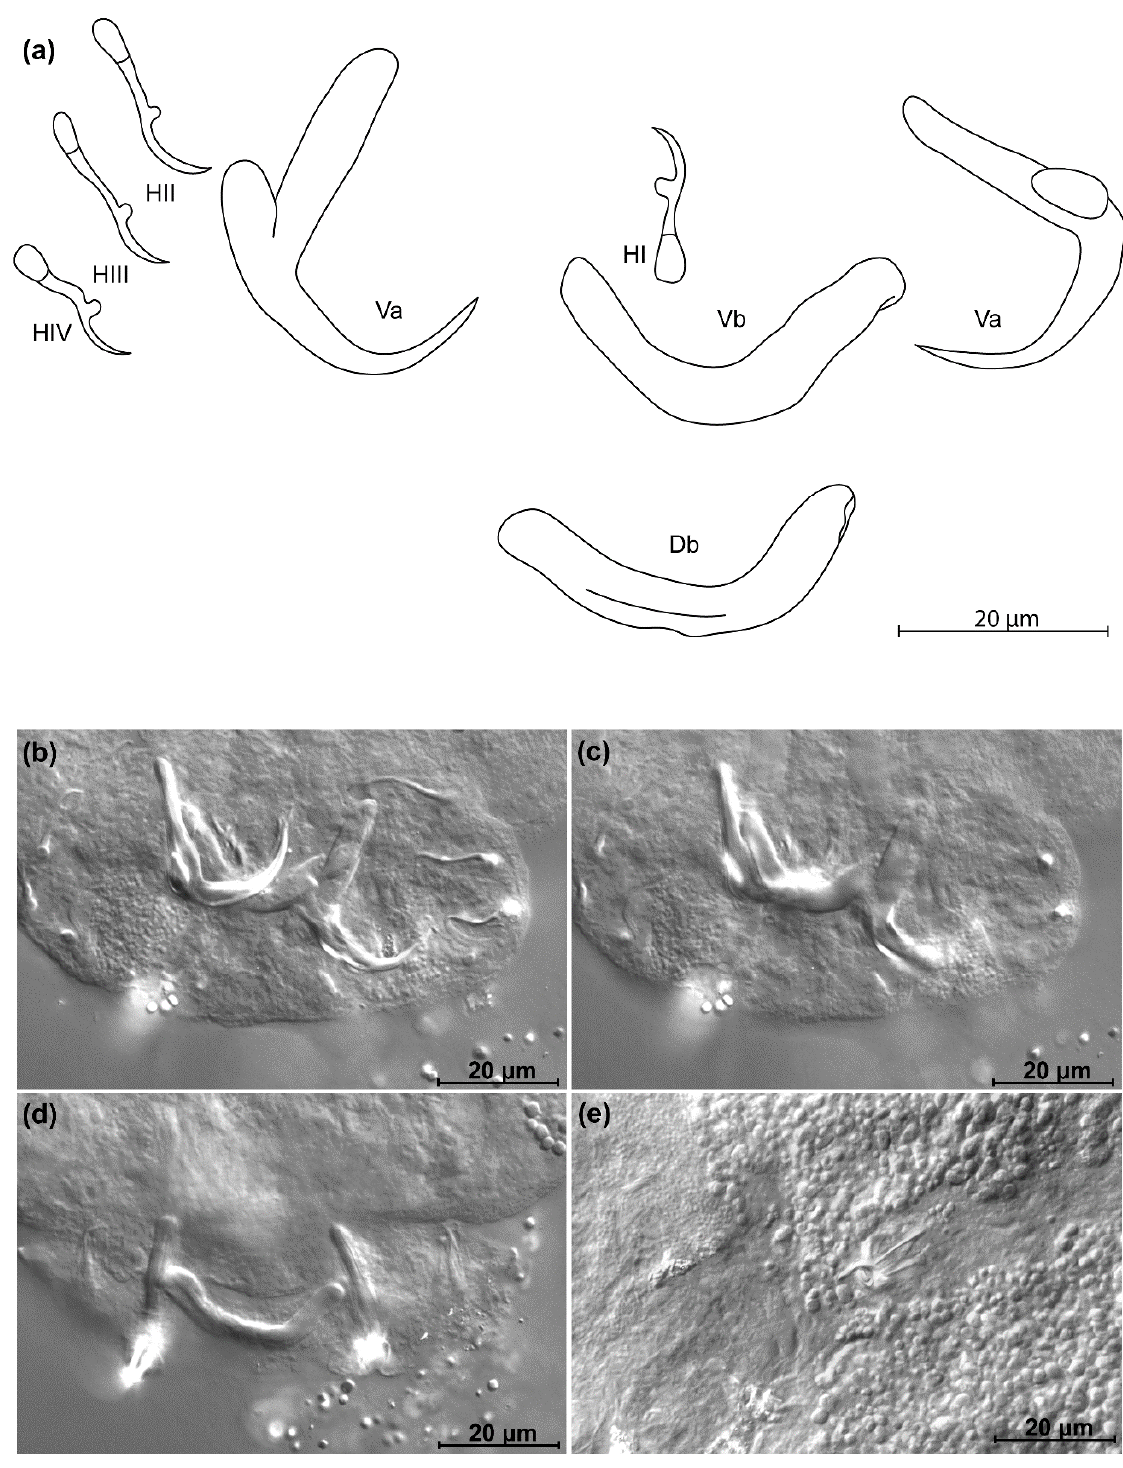
Figure 11. Kapentagyrus hahni n. sp. (ex Pellonula leonensis ). ( a ) Drawings of sclerotized structures, Va-ventral anchors, Db-dorsal bar, Vb-ventral bar, H-hooks (pairs I to IV—ventral). ( b ) Micrograph of ventral anchors and ventral bar. ( c ) Micrograph of dorsal anchors and dorsal bar. ( d ) Micrograph of dorsal anchors and dorsal bar. ( e ) Micrograph of MCO.